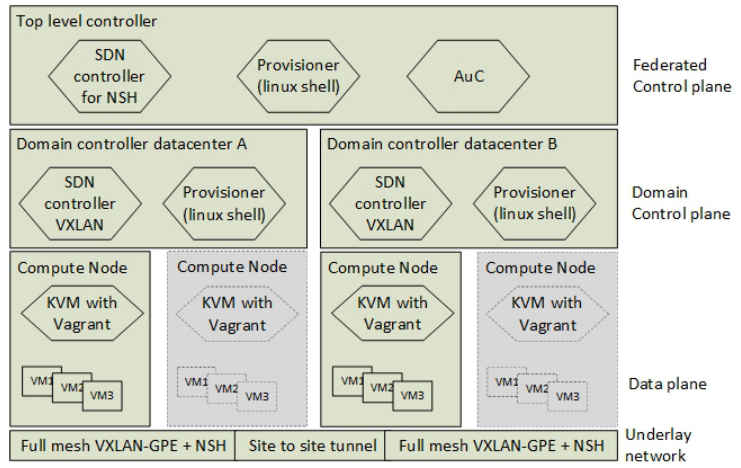
Figure 8. Hierarchy of network